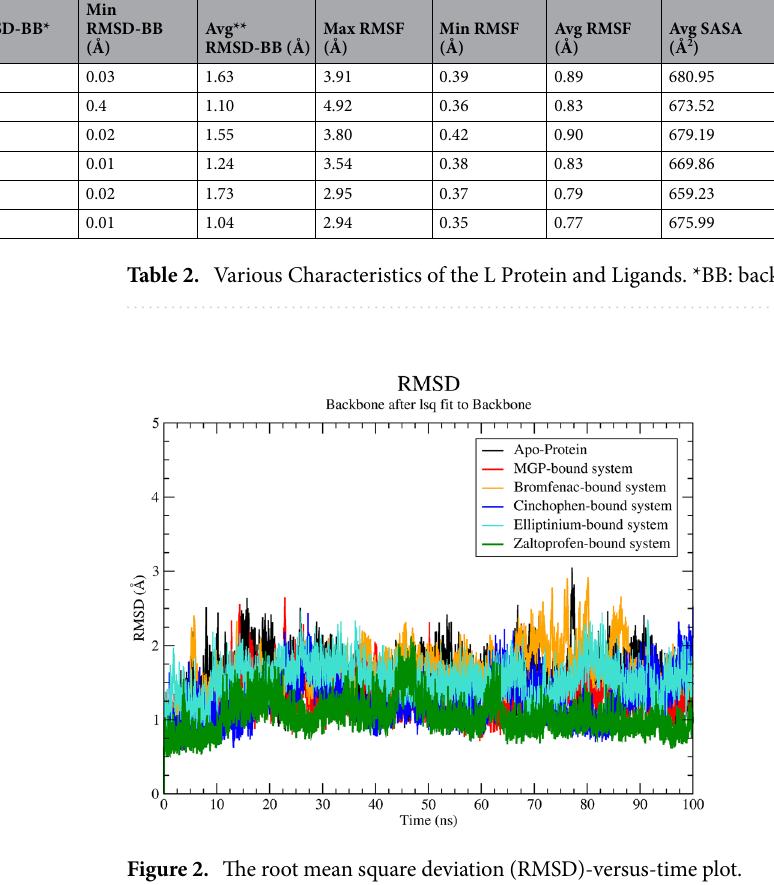
Figure 2. The root mean square deviation (RMSD)-versus-time